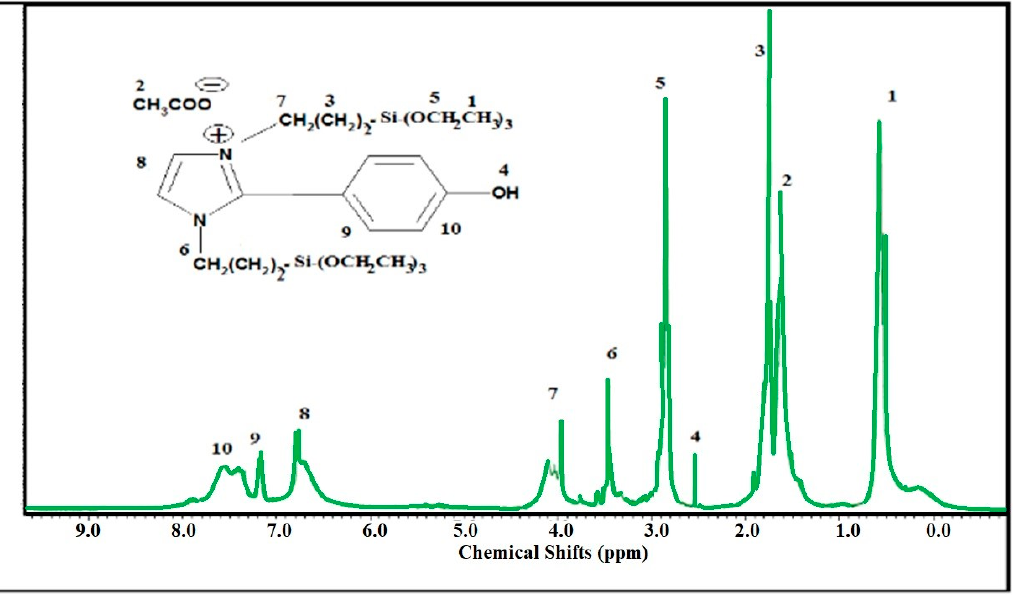
Figure 1. Hydrogen nuclear magnetic resonance ( 1 HNMR) spectrum of disiloxyimidazolium ionic liquid (SIMIL).